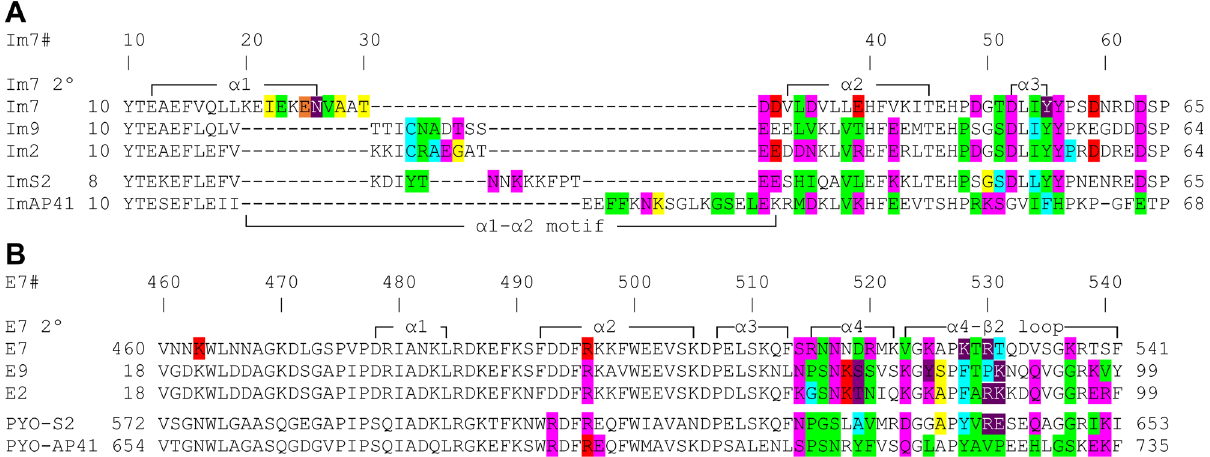
Figure 3. Residues in colicin–immunity protein complexes that are predicted to contribute to inter-molecular interactions in the E7-like family and the Im7-like family. ( A , B ) Residue-level sequence maps summarizing the structure-based energy calculations for the complexes of immunity proteins ( A ) with their cognate colicins/ pyocins ( B ). Residues that contribute substantially to interactions are colored according to the type of their energy contribution: non-polar contributions (np), green; side-chain electrostatic contributions (sc elec), red; main-chain electrostatic contributions (mc elec), yellow; sc elec and mc elec, orange; sc elec and np, magenta; mc elec and np, cyan; sc elec, mc elec and np, purple. Immunity protein and colicin/pyocin positions are numbered according Im7 (Im7#) and Col-E7 (E7#) and together with the Im7/Col-E7 secondary structure elements are shown above and below the alignment.